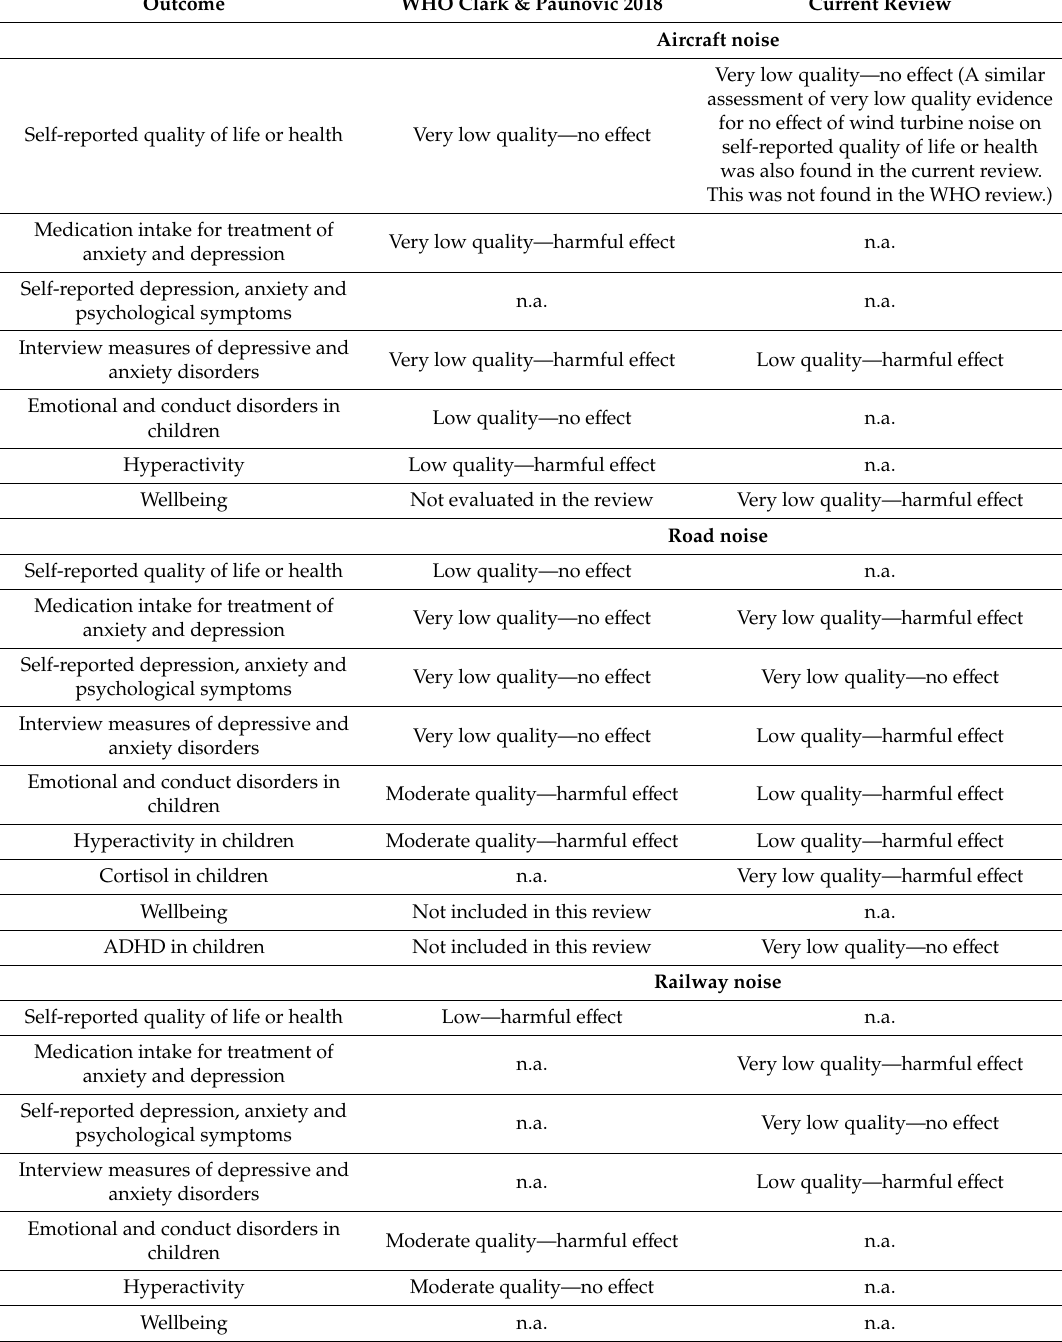
Table 12. Comparison of the strength of the evidence for the WHO 2018 and the current review for aircraft, road and railway noise and mental health, wellbeing and quality of life.